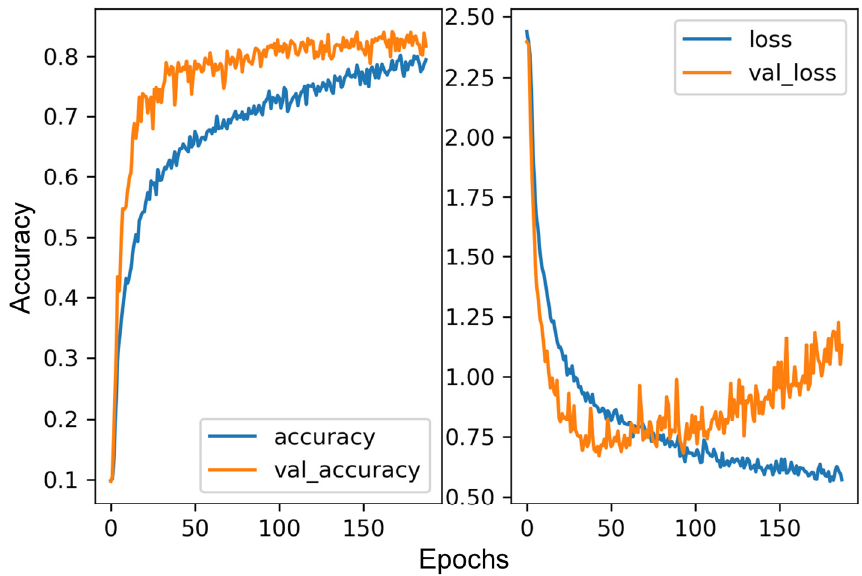
Figure 6. Learning curves of the baseline model with dropout.